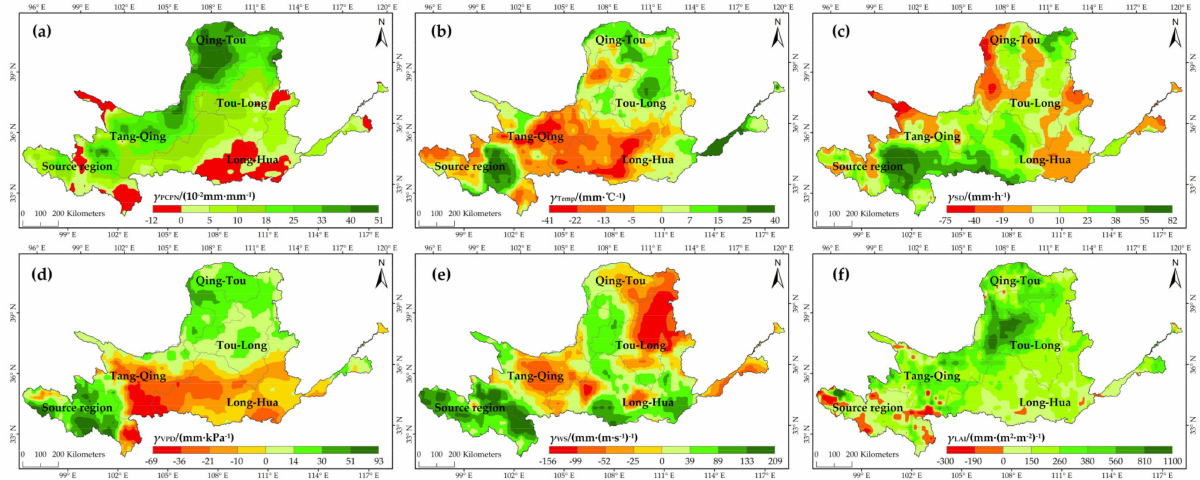
Figure 7. Spatial distribution of the sensitivity of ET to the ( a ) PCPN, ( b ) Temp, ( c ) SD, ( d ) VPD, ( e ) WS, and ( f )